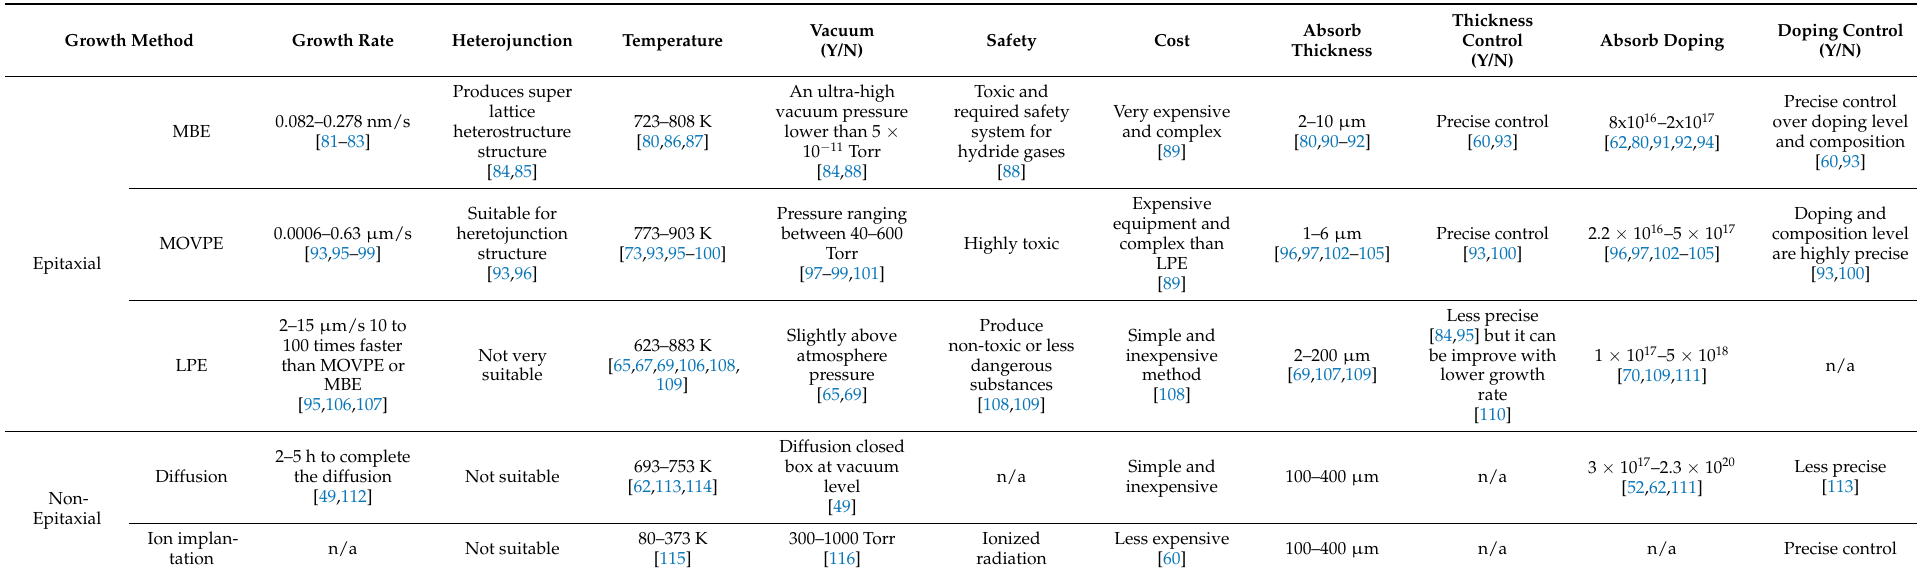
Table 1. Characteristics of Different Growth Methods for TPV